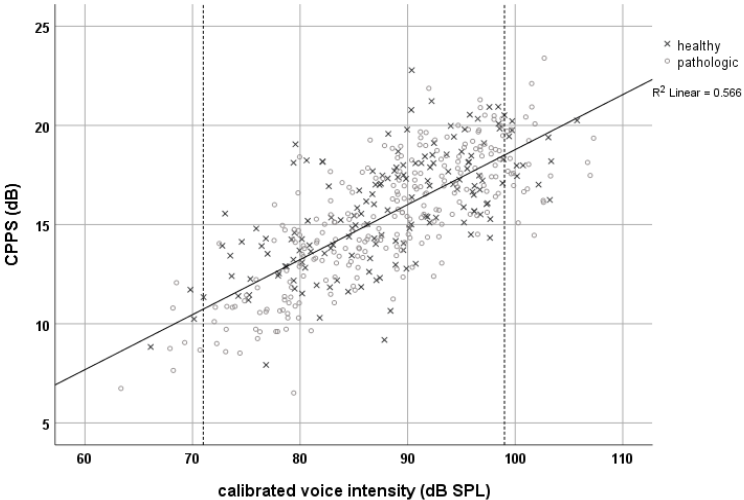
Figure 1. Smoothed Cepstral Peak Prominence (CPPS) with reference to sound pressure level (SPL) (@10 cm distance) in 58 voice-disordered and 58 age-matched, vocally healthy women. All phonated at individually “soft”, “comfortable”, and “loud” intensity levels. In this sample, “comfortable” phonation spanned a total range of 71–99 dB SPL (in between dashed lines) (Figure: own image, derived from [42,43]).